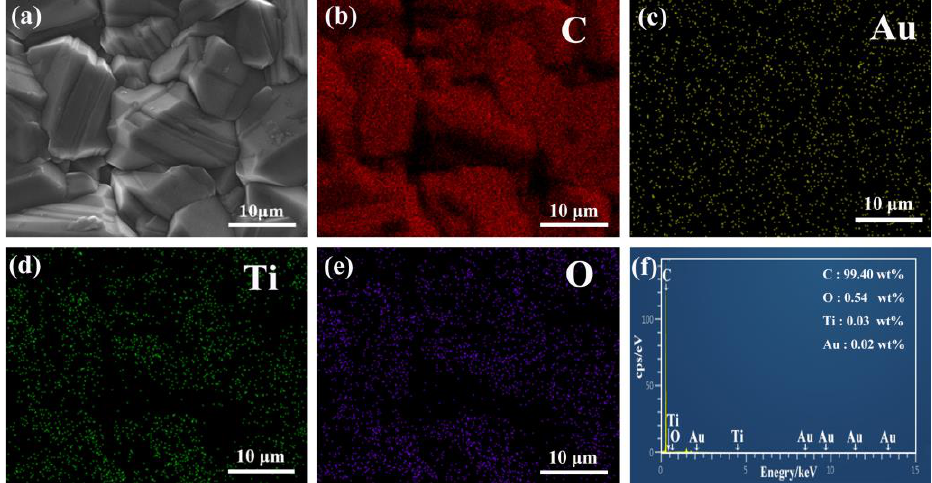
Figure 5. Elemental mapping images of TiO 2 /Au/BDD-30: ( a ) surface morphology of TiO 2 /Au/BDD-30; ( b – f ) EDS mapping distribution of TiO 2